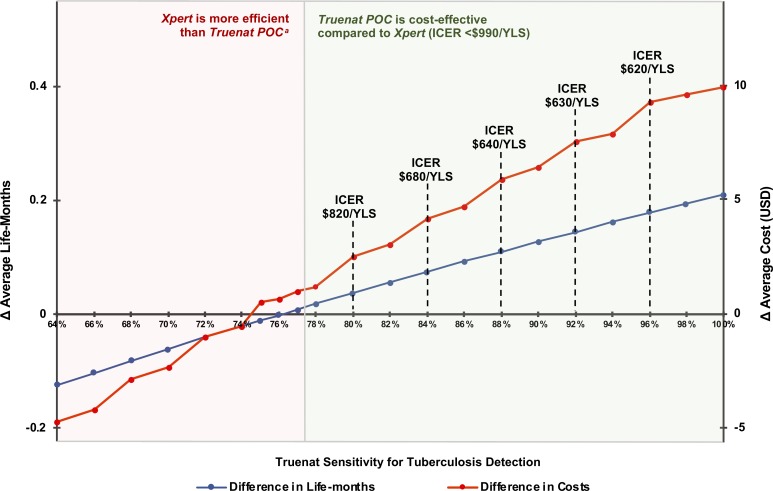
Sensitivity analysis of Truenat sensitivity for TB, comparing Truenat POC to Xpert at 5-year horizon.TB: tuberculosis. POC: point-of-care. ICER: incremental cost-effectiveness ratio. YLS: year-of-life saved. USD: United States dollars. This plot shows the differences in life expectancy and costs between Truenat POC and Xpert at a 5-year horizon when varying the sensitivity of Truenat for TB detection. The horizontal axis is the sensitivity of Truenat for TB detection. The blue line corresponds to the left vertical axis, which is the difference in life expectancy between Truenat POC and Xpert. The red line corresponds to the right vertical axis, which is the difference in per-person lifetime costs between Truenat POC and Xpert. The ICER (i.e., the difference in costs divided by the difference in life expectancy) is provided at regular intervals of test sensitivity values. For integer values of test sensitivity ≥78% (green panel), Truenat POC is cost-effective compared to Xpert (ICER <$990/YLS). For integer values <78% (red panel), Xpert is more efficient than Truenat POC. a“Xpert is more efficient than Truenat POC”: For Truenat sensitivity values <75%, Xpert was cost-effective compared to Truenat POC (ICER <$990/YLS). At Truenat sensitivity of 75–76%, Xpert was cost-saving (lower cost, higher clinical benefit [more life-years accrued]) compared to Truenat POC. At Truenat sensitivity of 77%, Xpert was decrementally cost-effective (lower cost and lower clinical benefit but with ICER >$990/year-of-life lost [YLL]—that is, at least $990 saved per year-of-life-lost) compared to Truenat POC.